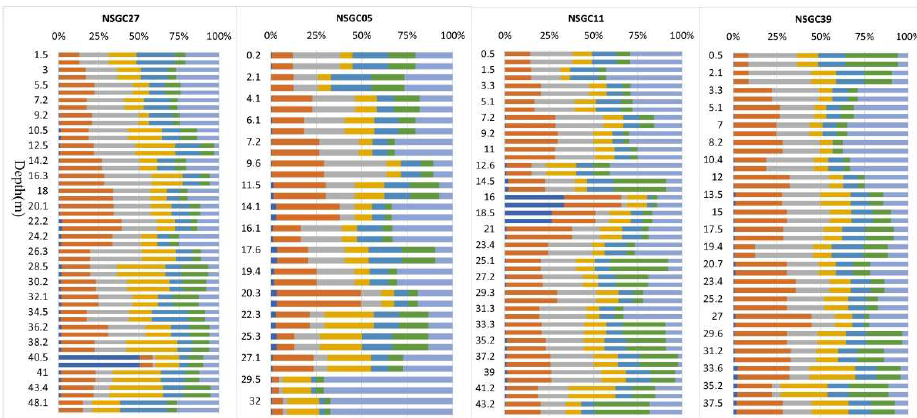
Figure 9. Percentage of Cd fractionation in each core.